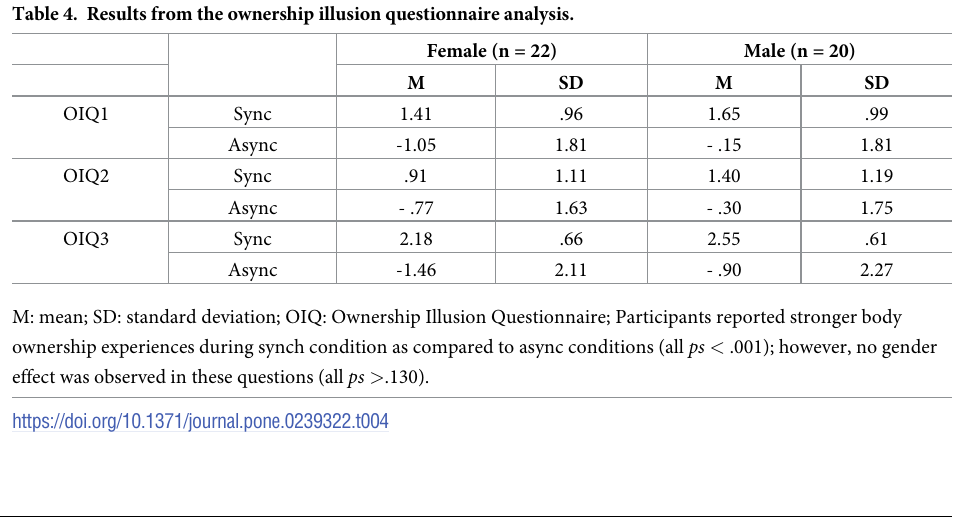
Table 4. Results from the ownership illusion questionnaire analysis.